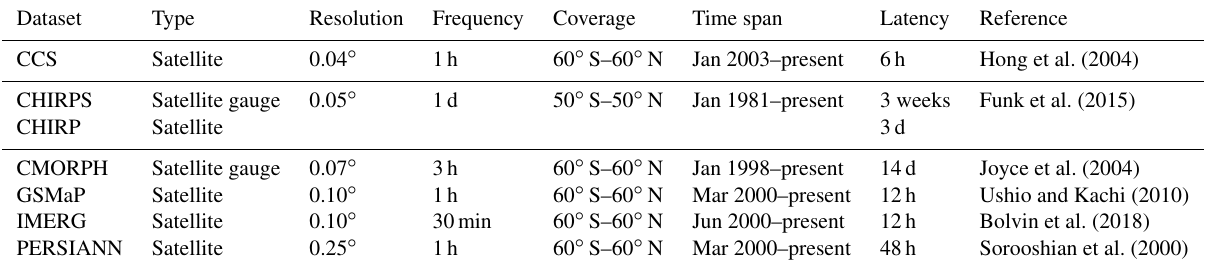
Table 1. Main features of the selected (quasi-)global precipitation datasets. Dataset